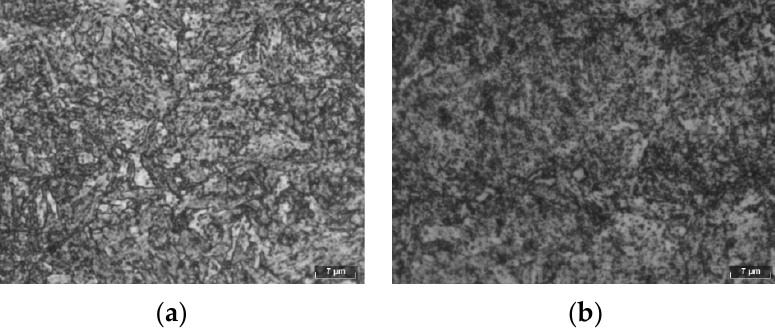
Figure 4. Light optical microscope ( LOM) images of microstructure in bright ( a ) and dark ( b ) bands.